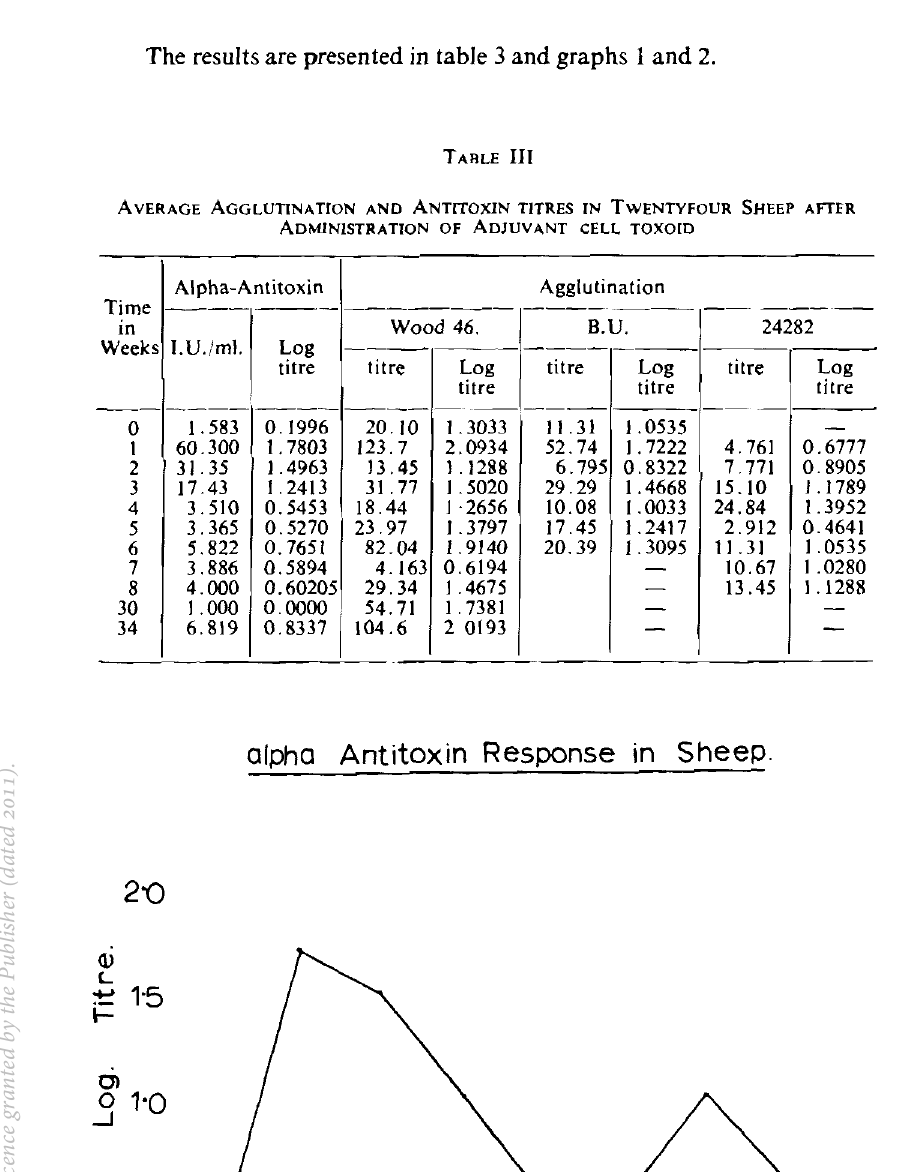
AVERAGE AGGLUTINATION AND ANTITOXIN TlTRES TN TWENTYFOUR SHEEP AYTfR ADMINISTRATION OF ADJUVANT CELL